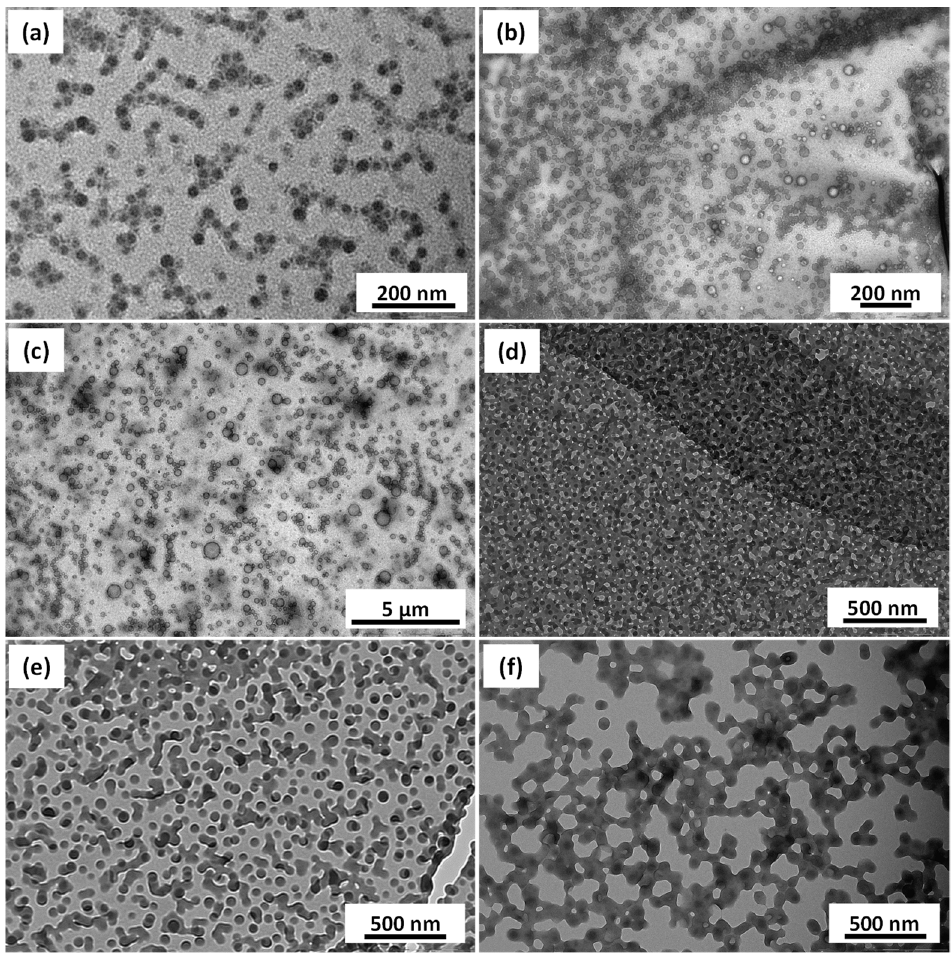
Figure 7. TEM images obtained for PDMA 58 -PBzMA x -PTDFOA y self-assembled nano objects pre- pared at 10% w / w by RAFT dispersion polymerization of PTDFOA in ethanol, with ( a ) x = 69, y = 48 ( b ) x = 69, y = 91 ( c ) x = 69, y = 144 ( d ) x = 194, y = 44 ( e ) x = 194, y = 83 ( f ) x = 194, y = 120.